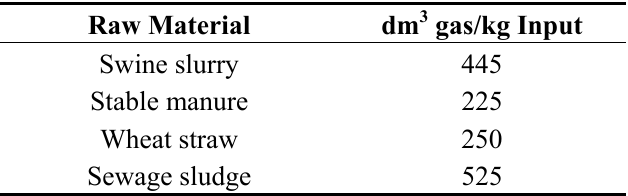
Table 3. Biogas production yields